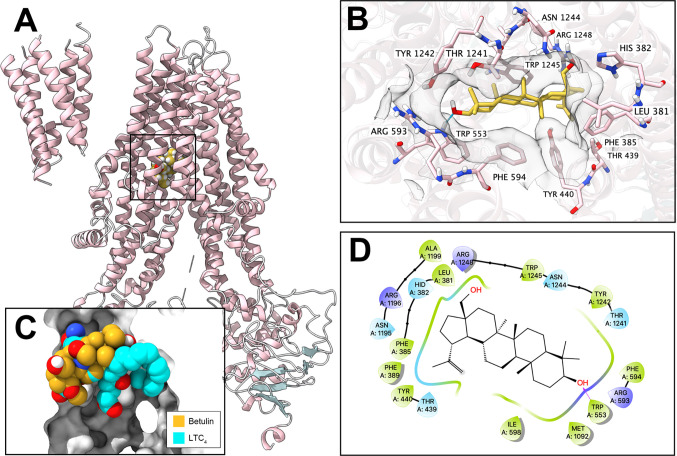
Interaction between betulin and human ABCC1 protein. (A) Overview of the best-scoring pose of betulin in the drug-binding pocket of ABCC1 protein (5UJA). ABCC1 was displayed as colored ribbons (helix: pink; strand: blue; coil: white). Betulin was displayed as colored balls. (B) Details of the interactions between betulin and ABCC1 (5UJA) binding pocket. ABCC1 helices were displayed as colored ribbons. Important residues were displayed as colored sticks (carbon: pink; oxygen: red; nitrogen: blue; hydrogen: white; fluoride: lime; chloride: light green). Surface formed by important residues were depicted as grey solid planes. Betulin was displayed as colored sticks (carbon: yellow; oxygen: red; nitrogen: blue; chloride: lime; fluoride: light green). Hydrogen bonds were displayed as blue dash lines. (C) Binding poses of betulin and ABCC1 substrate LTC4 in ABCC1 binding pocket. (D) 2D diagram of the interaction between betulin and ABCC1. Amino acids within 3 Å from betulin were displayed as colored bubbles (green: hydrophobic; blue: polar). Purple solid lines with arrow indicate hydrogen bonds.